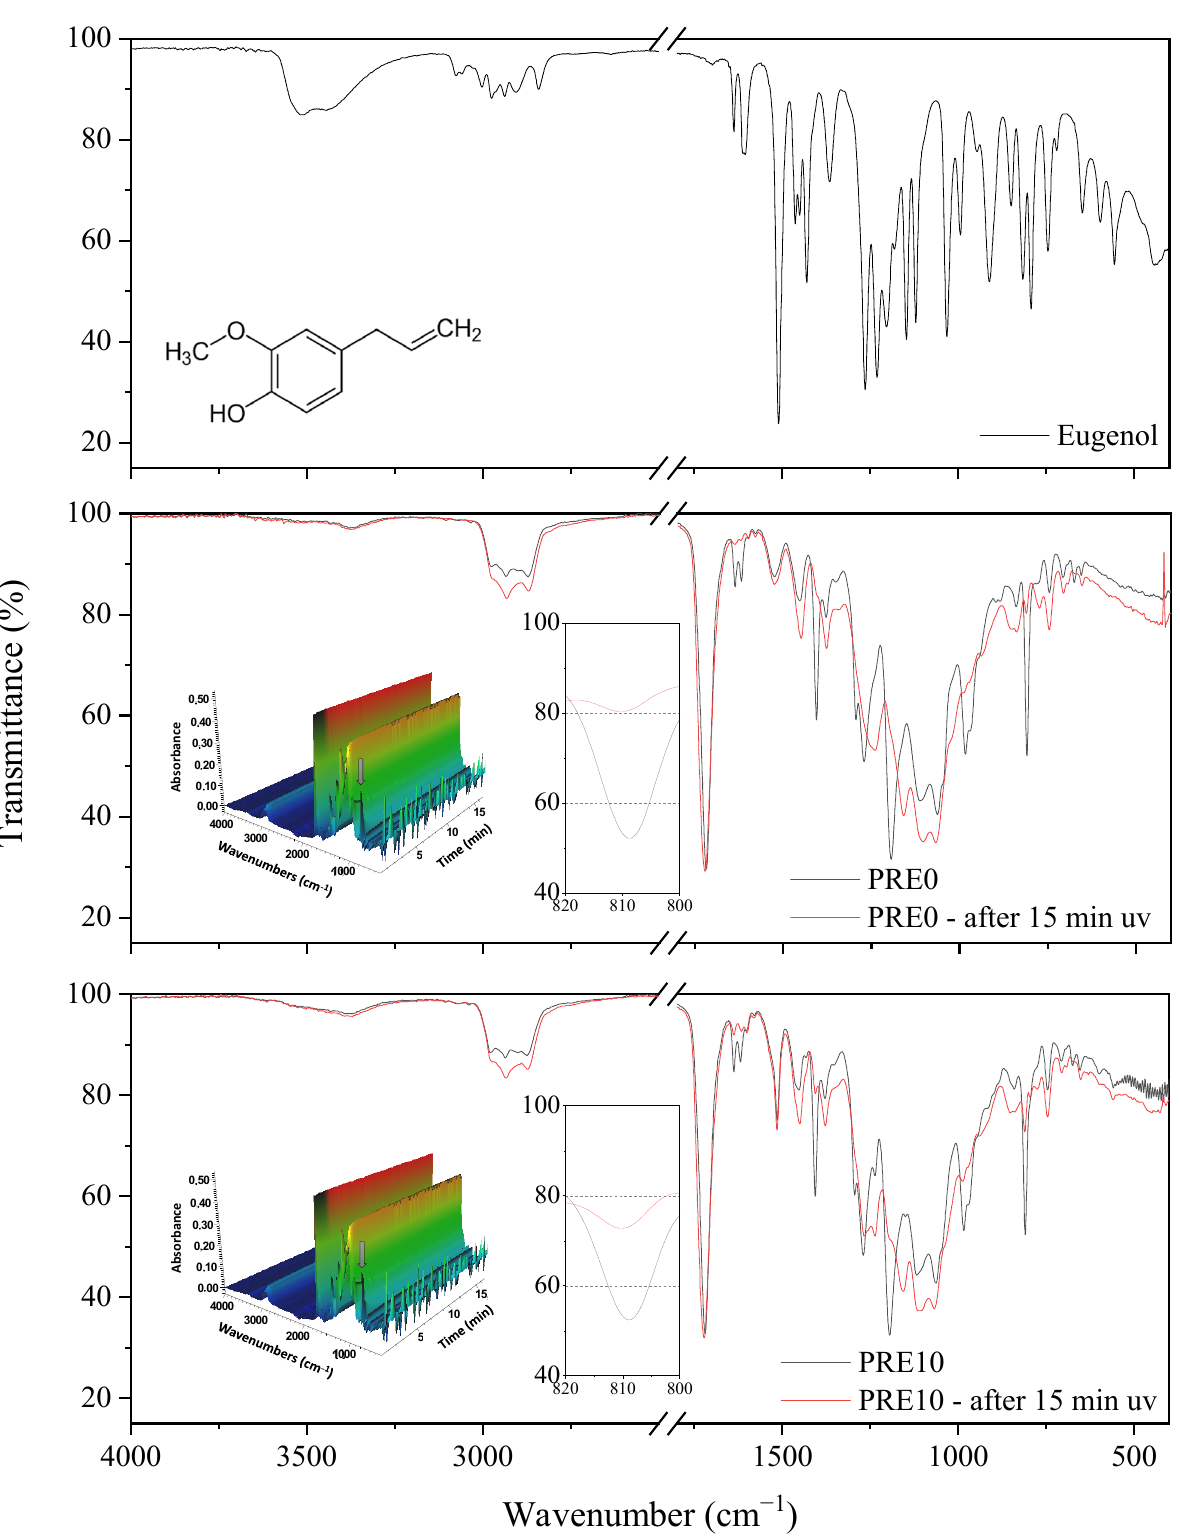
Figure 2. FTIR spectra of eugenol unmodified (PRE0) and modified (PRE10) urethane acrylate resin before and after exposure to the UV radiation.